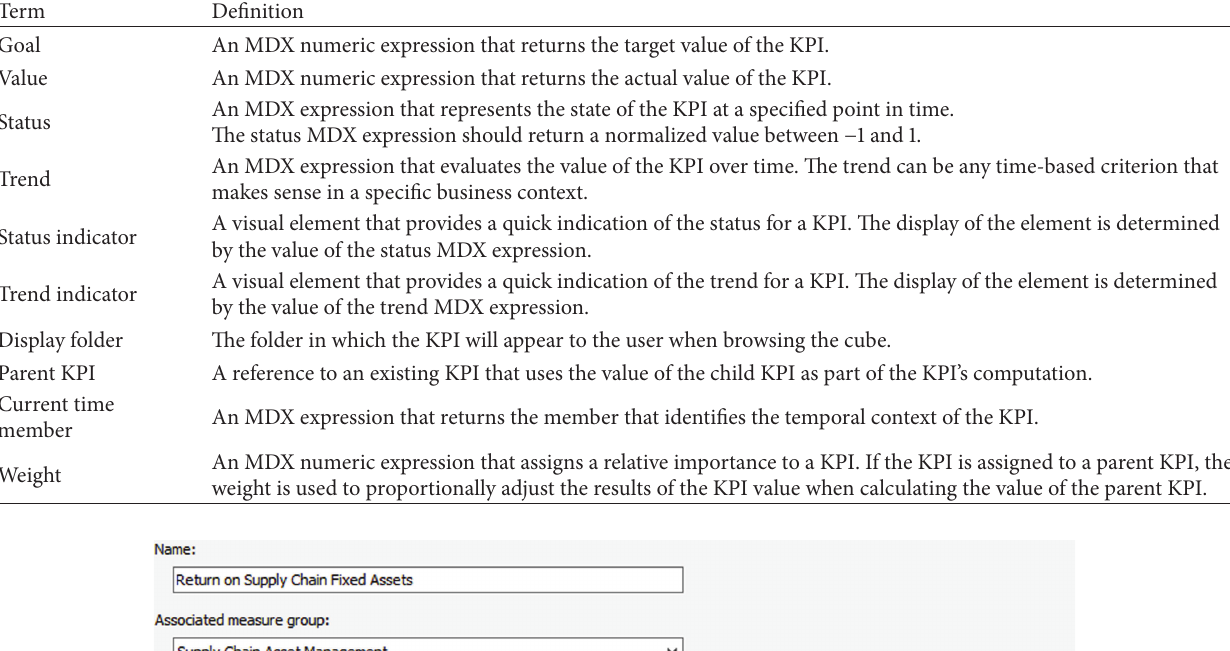
Table 1: OLAP KPI structure.